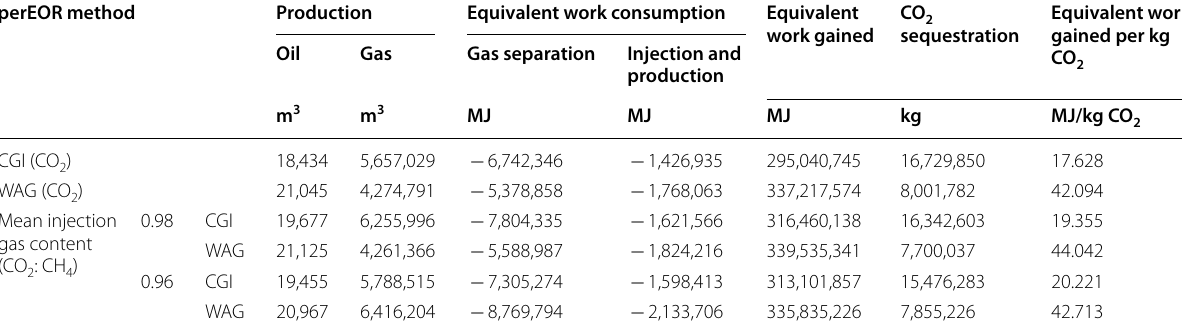
Table 3 Influence of the CH contents of injected gas on the energy budget of EOR 4 perEOR method Production Equivalent work